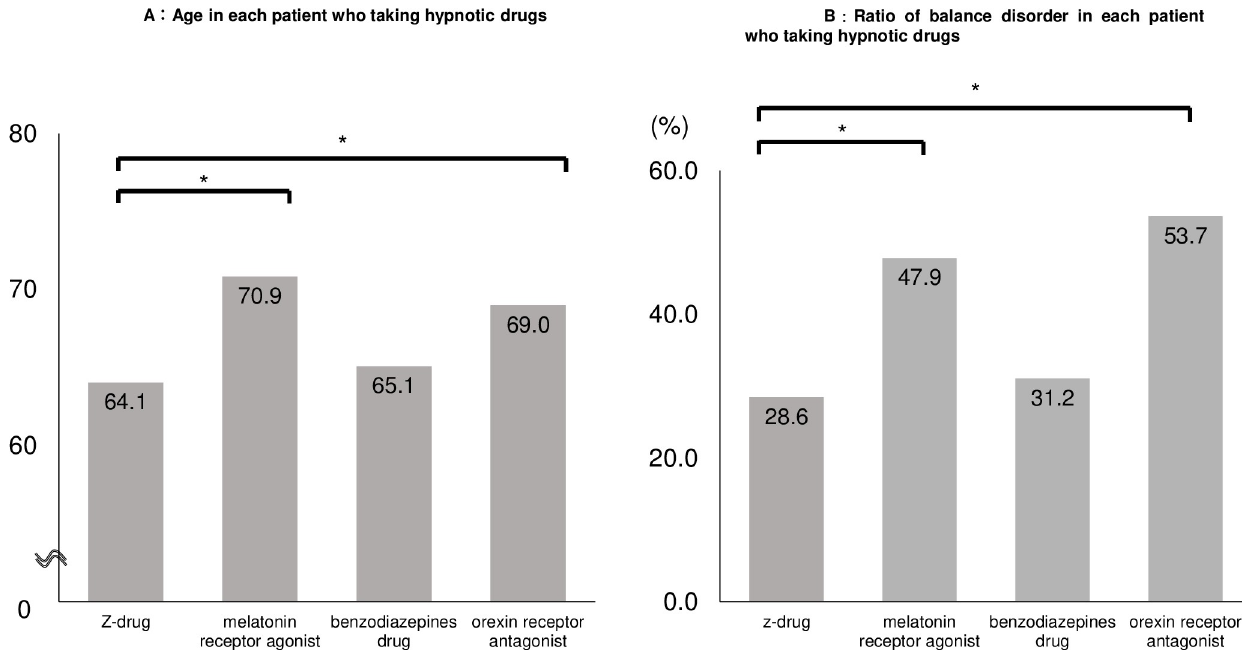
Fig 4. Age and ratio of balance disorder and each patient who was prescribed hypnotic drugs. The patients taking z-drugs were significantly younger than those taking melatonin receptor agonists and orexin receptor antagonists. The ratio balance disorder in the patients taking z-drugs was significantly smaller than that of melatonin receptor agonists and orexin receptor antagonists. � : means statistically significant.